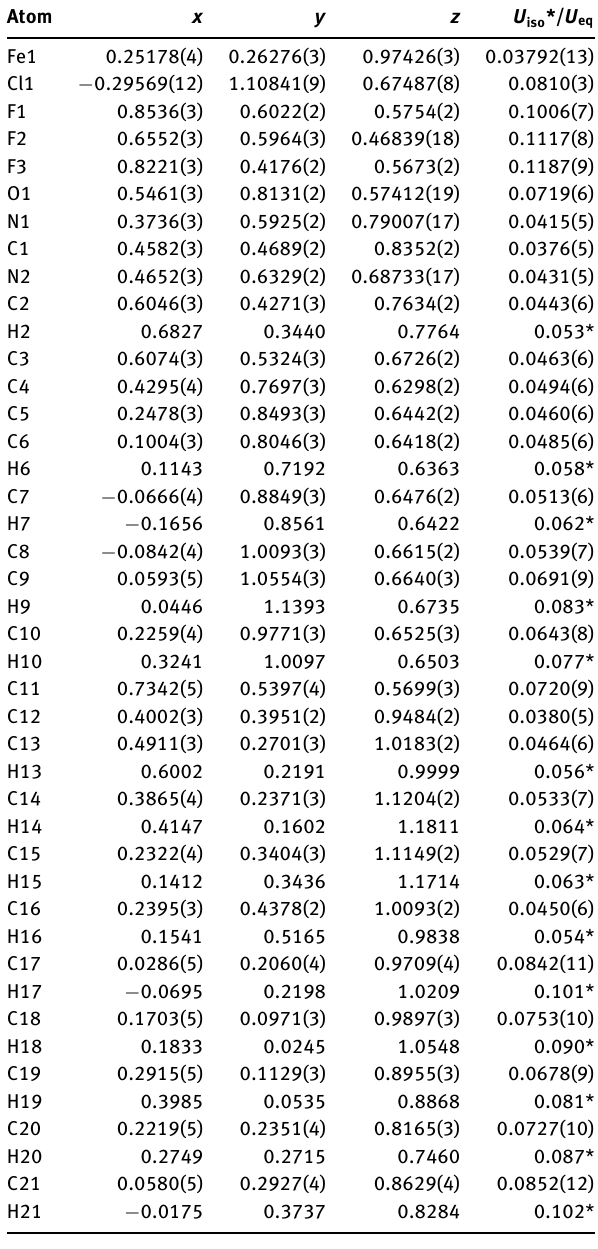
Table 2: Fractional atomic coordinates and isotropic or equivalent isotropic displacement parameters (Å 2